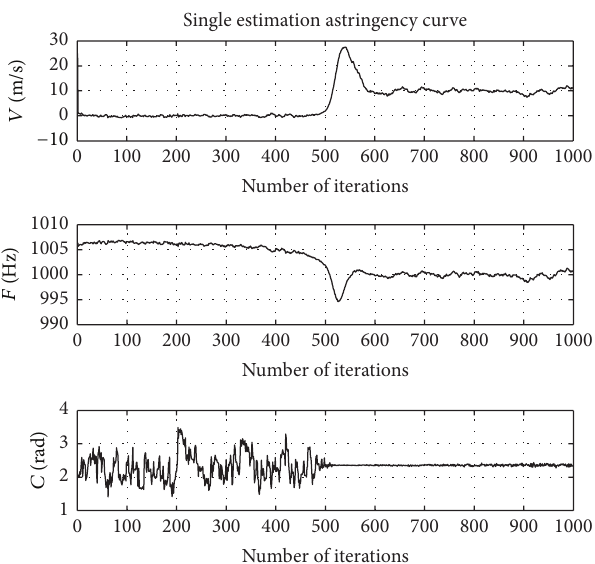
Figure 9: Estimation astringency curve of speed, frequency, and